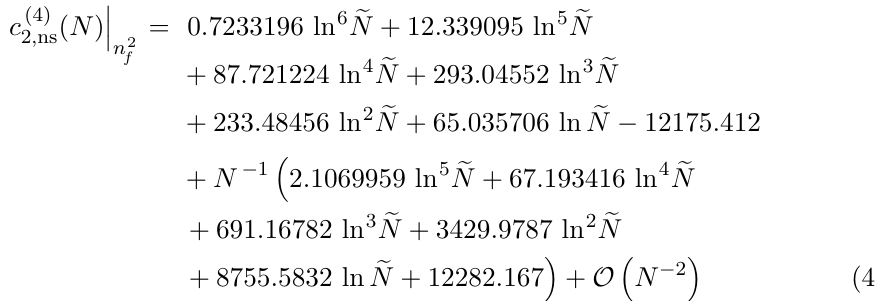
Figure 3 . The leading (dashed) and sub-leading (solid) large- n (left panel) and four-loop (right panel) coefficient functions for the structure function F L, ns for QCD with n = 4 flavours. The results in eqs. (4.4)–(4.16) have been converted to an expansion in α s , f and the leading large- n curves have been scaled up by a factor of 10 for better f